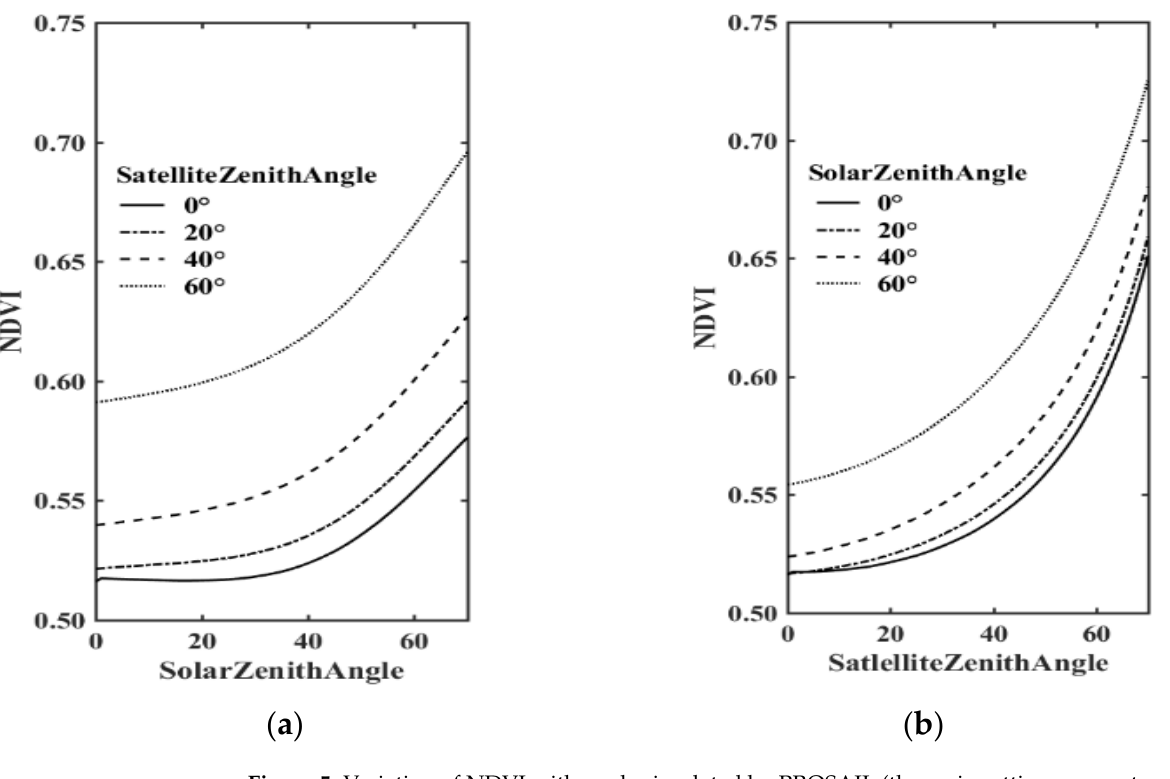
Figure 5. Variation of NDVI with angle simulated by PROSAIL (the main setting parameters are as follows: chlorophyll content = 40 (ug · cm − 2 ); carotenoid content = 8 (ug · cm − 2 ); brown pigment content = 0.0 (arbitrary units); equivalent water thickness = 0.01 (cm); dry matter content = 0.009 (g · cm − 2 ); leaf structure parameter = 2.5; leaf area index = 0.5 (m 2 /m 2 ); hot pot = 0.01). ( a ) Variation of NDVI with solar zenith angle and ( b ) Variation of NDVI with satellite zenith angle.